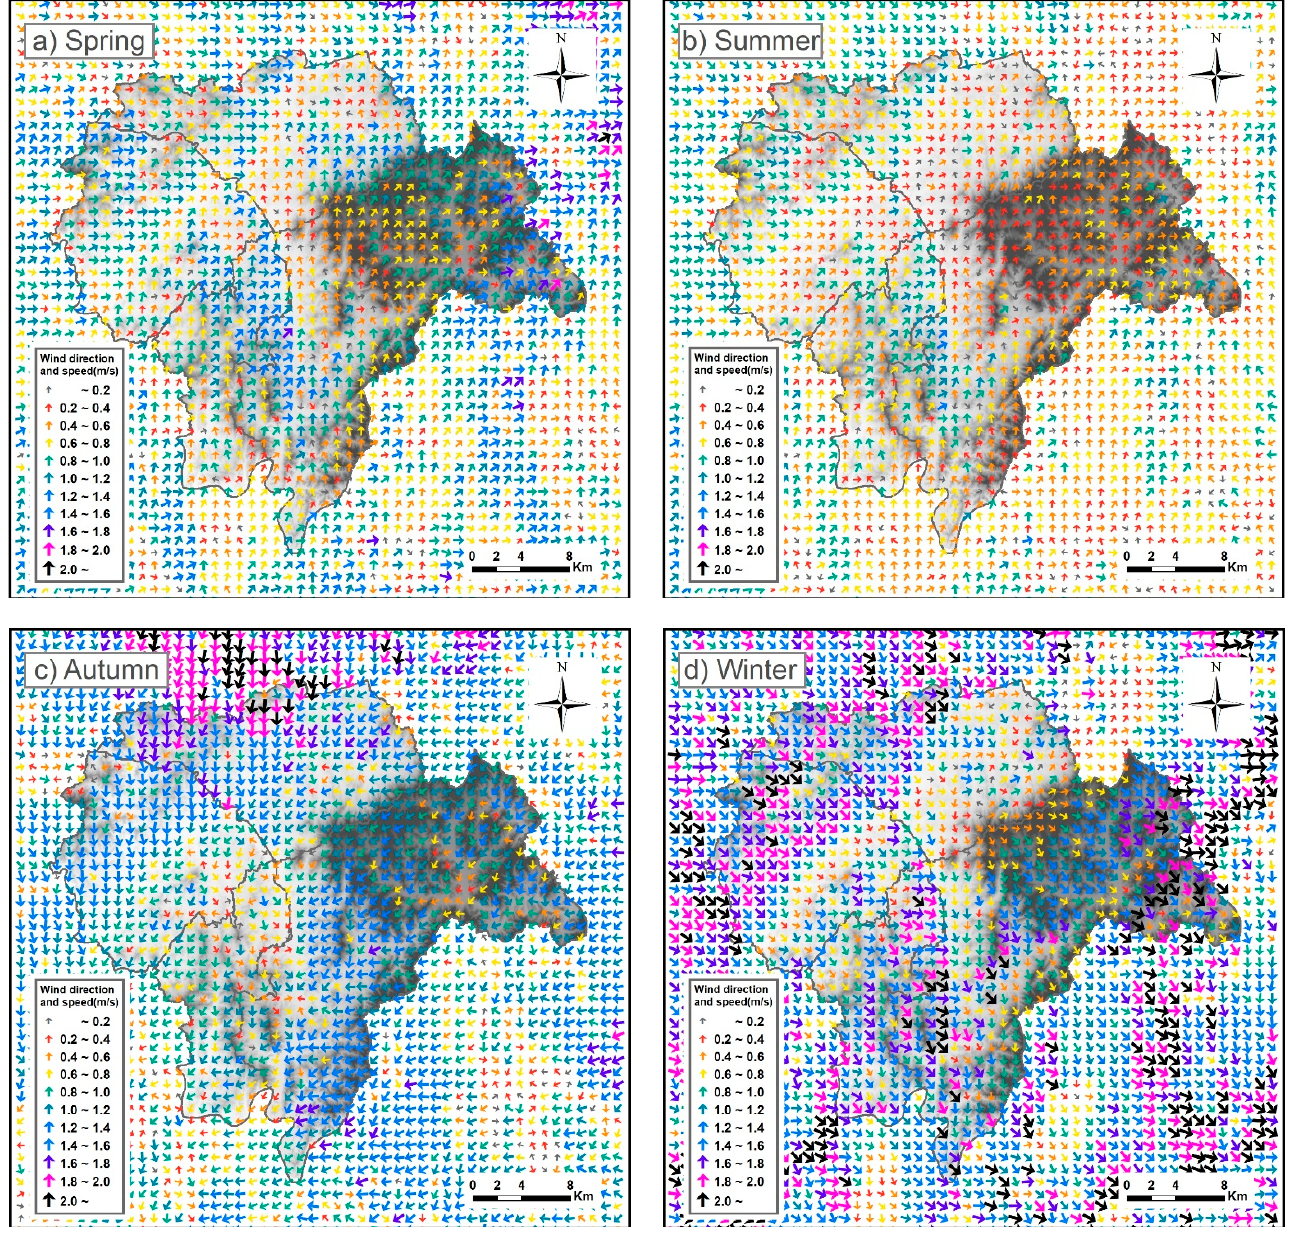
Figure 5. Wind field map of Cheongju-si, Korea by season: ( a ) spring, ( b ) summer, ( c ) autumn, ( d ) winder.